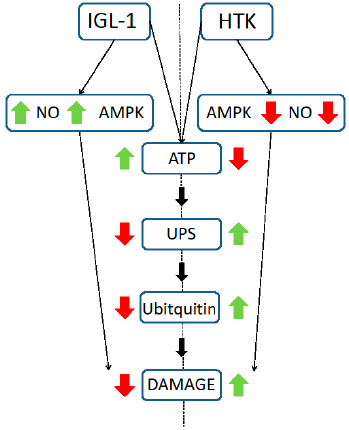
Figure 6. Differential protective mechanisms in fatty liver preservation during graft cold storage. Increases (green arrows) and decreases (red arrows) are represented at each side of the scheme (left side corresponding to IGL-1 solution and right side corresponding to HTK solution).